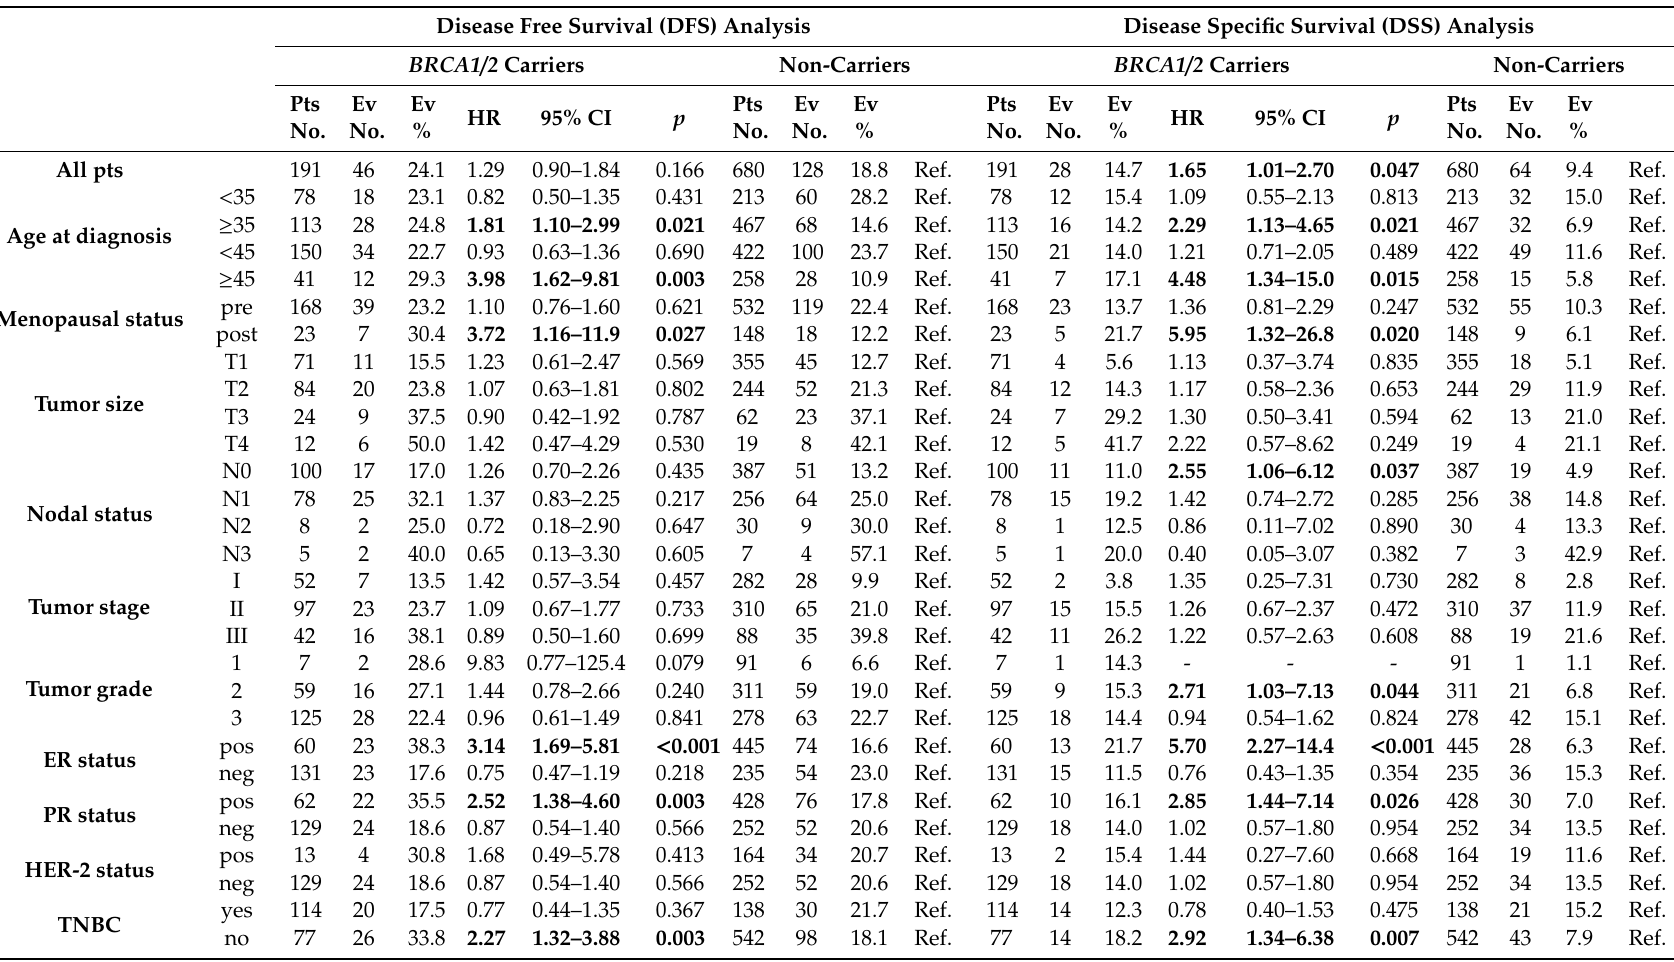
Table 2. Analysis of 10-year DFS and DSS using the Mantel–Haenszel test comparing variables between BRCA1 / 2 mutation carriers and